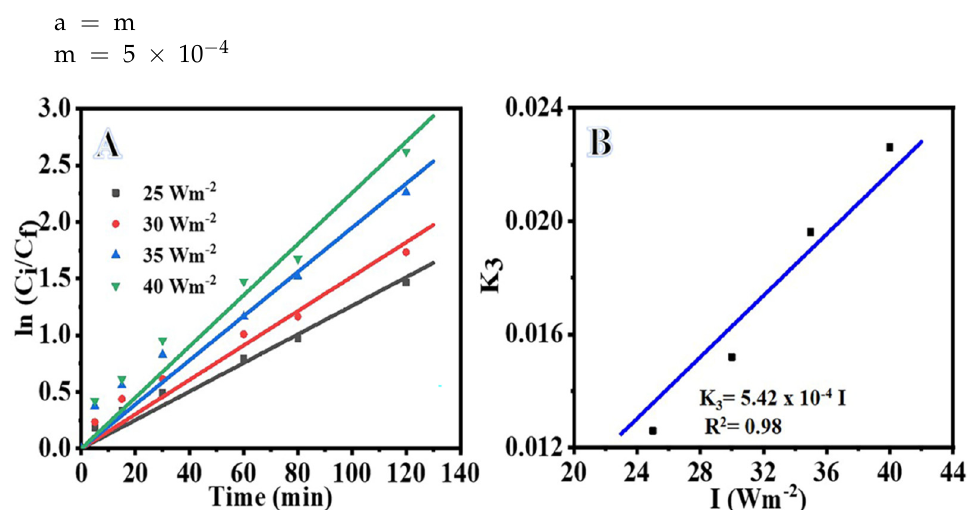
Figure 7. Influence of light intensity on photodegradation of MB, ( A ) ln C i /C f vs. time ( B ) plot of K 3 vs. I. The parameters are: photocatalyst amount = 0.2 gm L − 1 , C i = 0.1 M and T = 298 K.